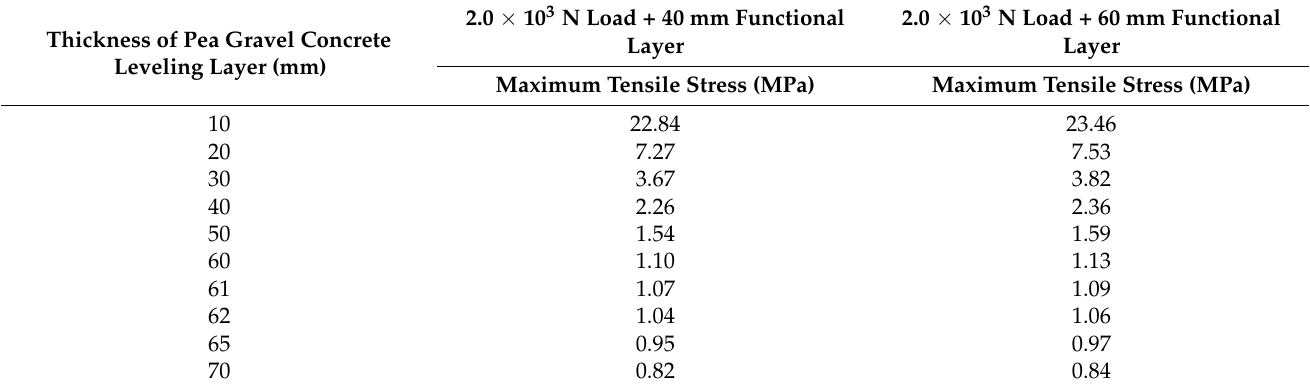
Table 2. Corresponding table of thickness and maximum tensile stress of pea gravel concrete leveling layer.